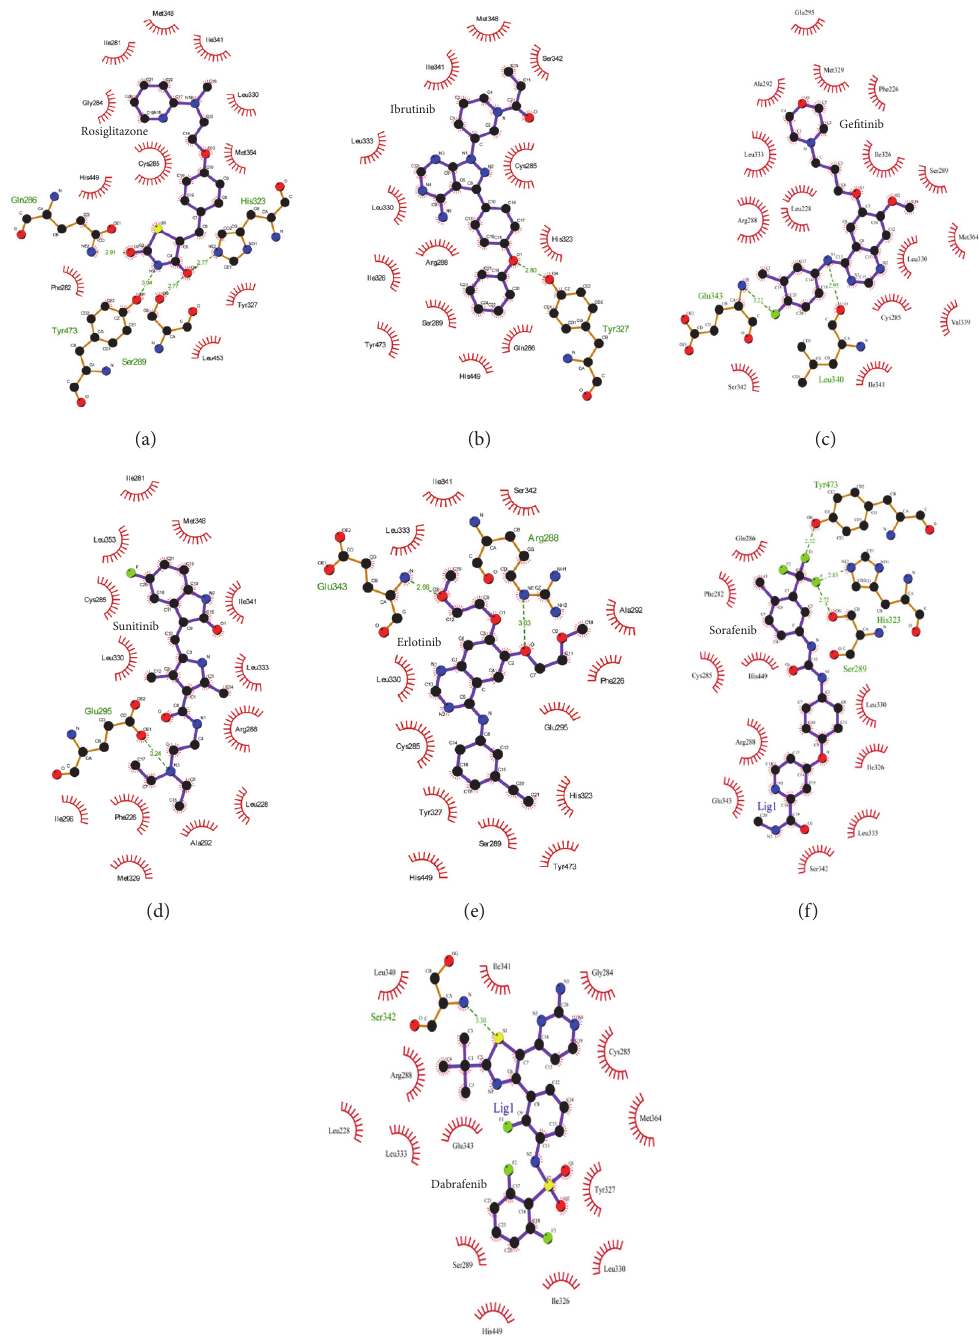
Figure 2: 2D-docking pose showing KIs and rosiglitazone in the binding site of human PPAR 𝛾 using LigPlot software. The interactions shown are those mediated by hydrogen bonds and by hydrophobic contacts. Hydrogen bonds are indicated by dashed lines between the atoms involved, while hydrophobic contacts are represented by an arc with spokes radiating towards the ligand atoms they contact. The contacted atoms are shown with spokes radiating